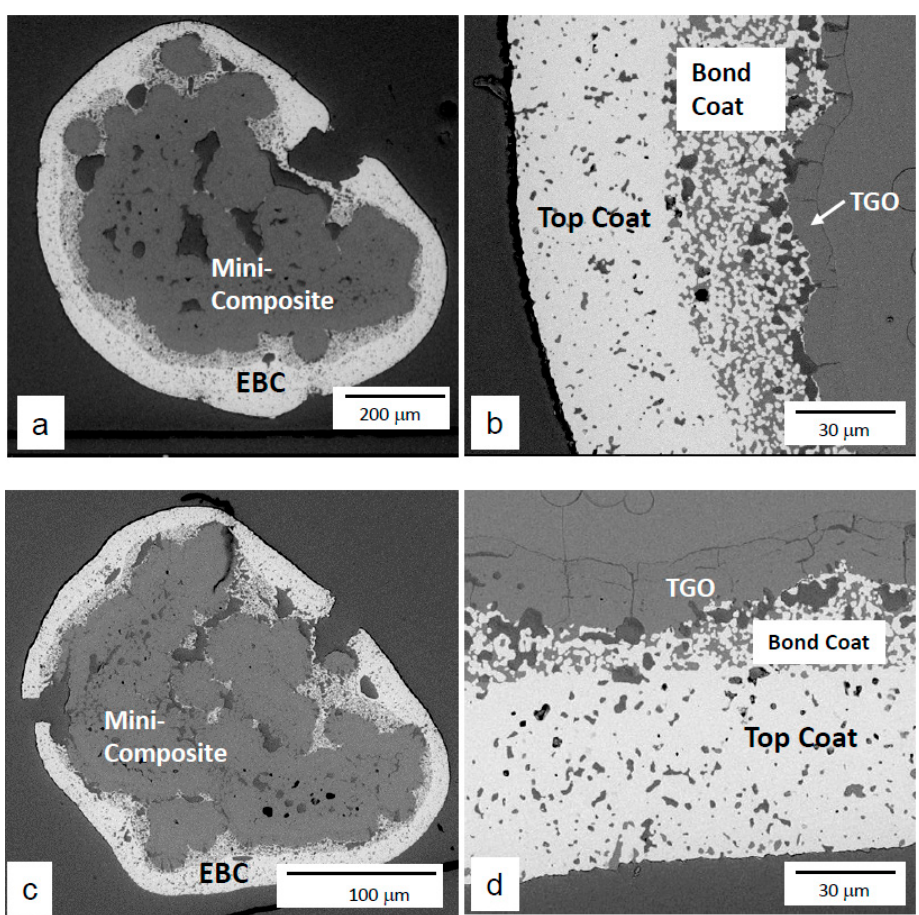
Figure 7. Cross-section of mini-composite after cyclic oxidation at 1427 °C in 90 vol.% H 2 O + 10 vol.% O 2 : ( a , b ) 100 h; ( c , d ) 300 h.